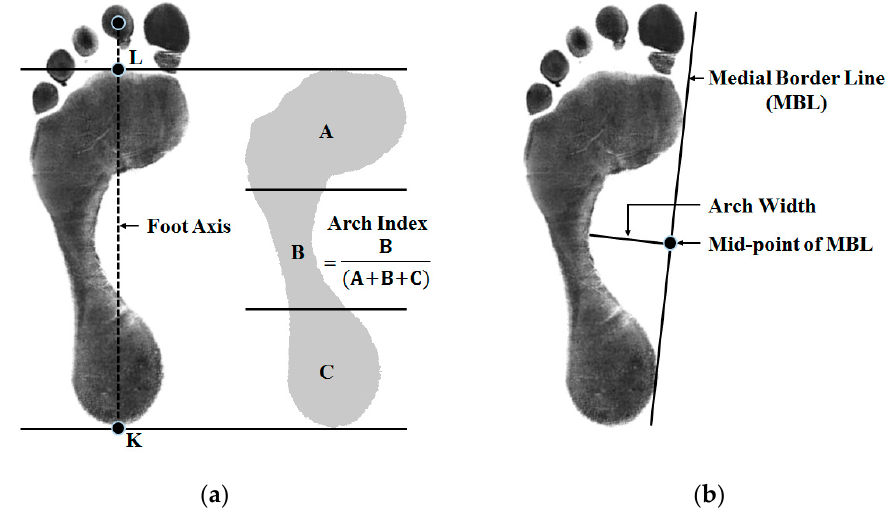
Figure 1. Definitions of foot-arch parameters: ( a ) arch index (AI) measurement from the footprint, ( b ) arch width (AW) and height (AH) measurement.